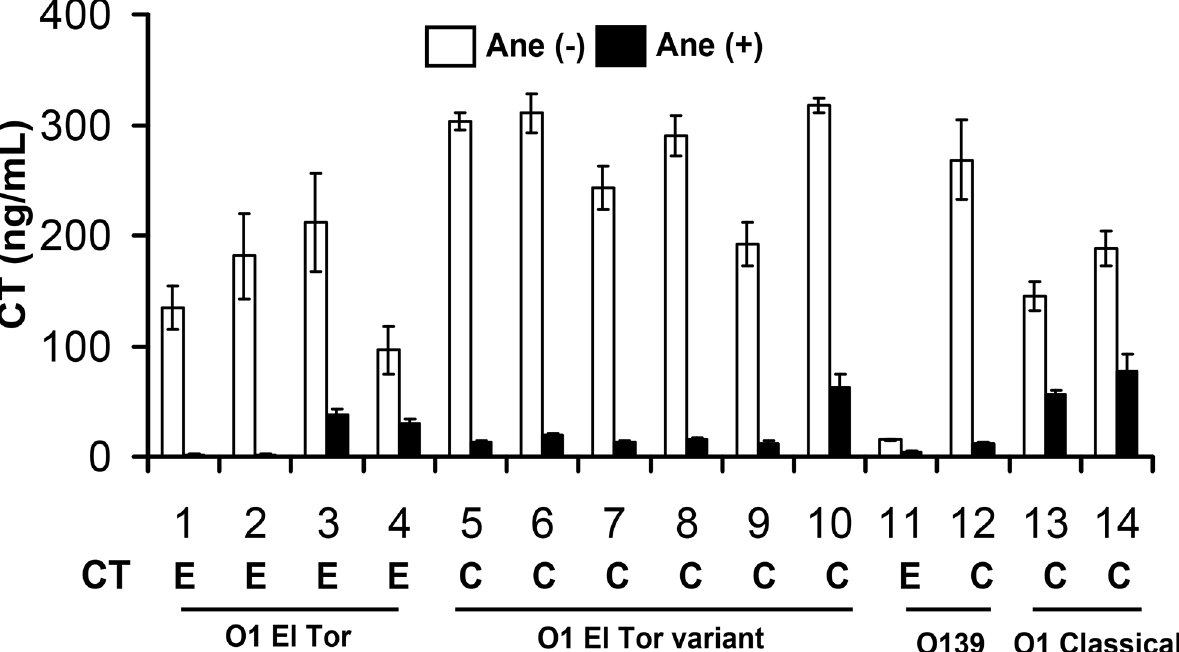
Fig 1. Effect of anethole on CT production in V . cholerae . Anethole (50 μ g/ml) drastically inhibited CT production in various serogroups and biotypes of V . cholerae . Open and close bars indicate CT production level as ng/ml without and with anethole, respectively. Numerical values in the x -axis represent the strain identity (see Table 1). ‘ E ’ and ‘ C ’ represent the presence of El Tor and classical type ctxB gene allele, respectively in the analyzed strains. Serogroups/ biotypes of the V . cholerae strains are described below the respective ctxB allele. Values represent the averages ± SD of three independent experiments.